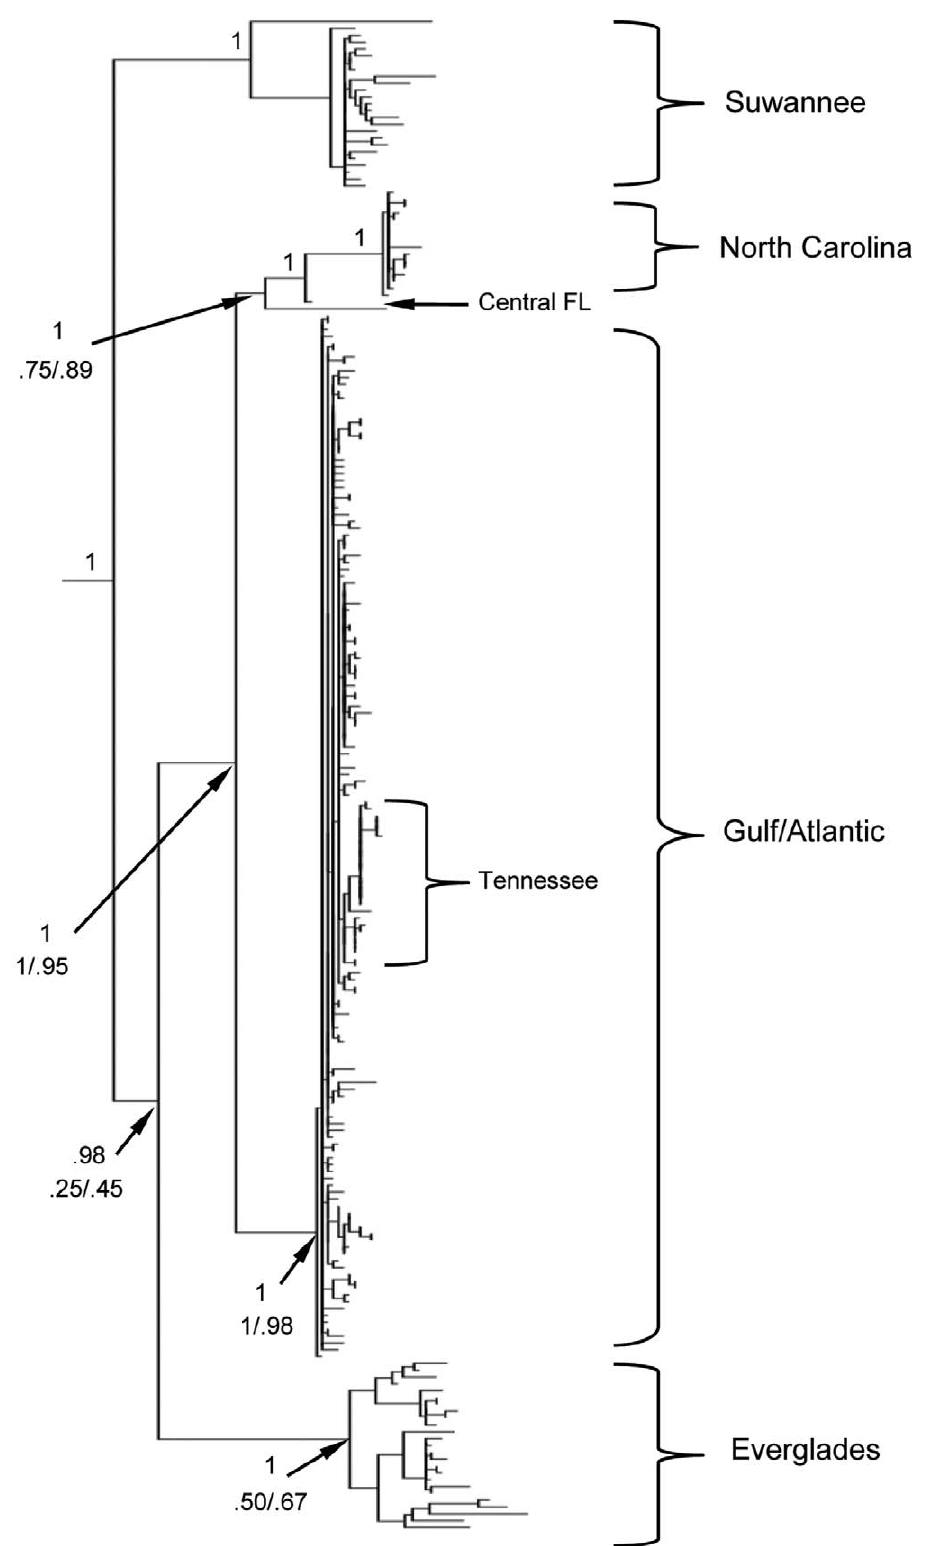
Figure 2. Phylogenetic reconstruction of the ND2 mitochondrial region. The most likely tree derived from the rapid bootstrap method (RBS) in RaxML is shown; the topologies of three methods (RBS, full likelihood, and Bayesian inference) were highly concordant. Posterior probabilities are given above important nodes; below nodes are the bootstrap values from RBS before the slash and from the full ML analysis after the slash. Nodes with 100% support in all three analyses are indicated with a 1. Outgroups ( A. isolepis , A. altitudinalis and A. porcatus ) are not shown. The four major